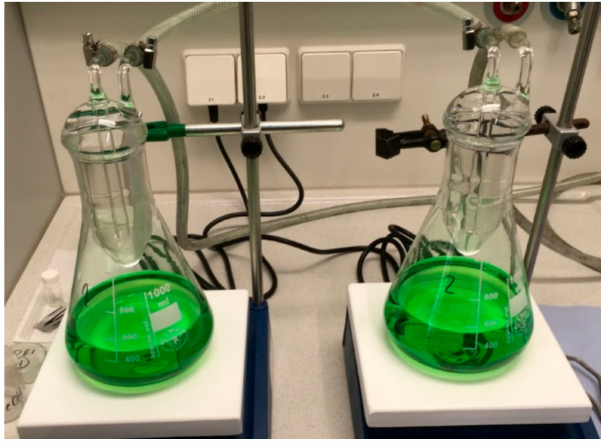
Figure 12. Sample exposure setup.